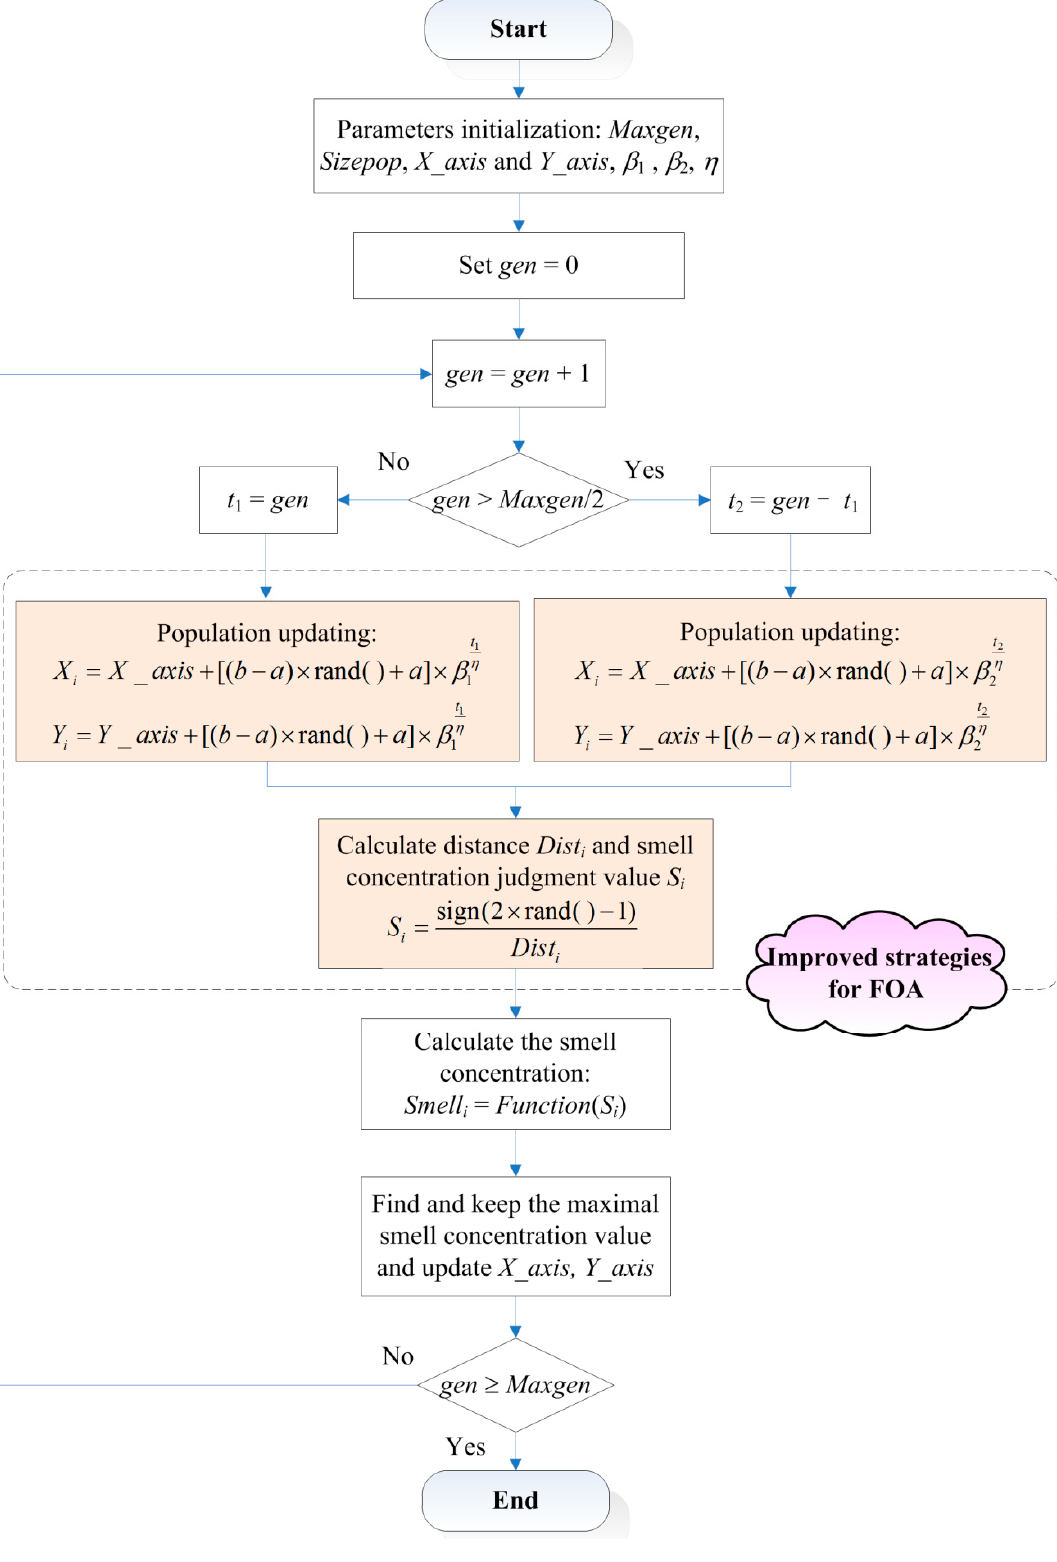
Figure 2. The flowchart of improved FOA.